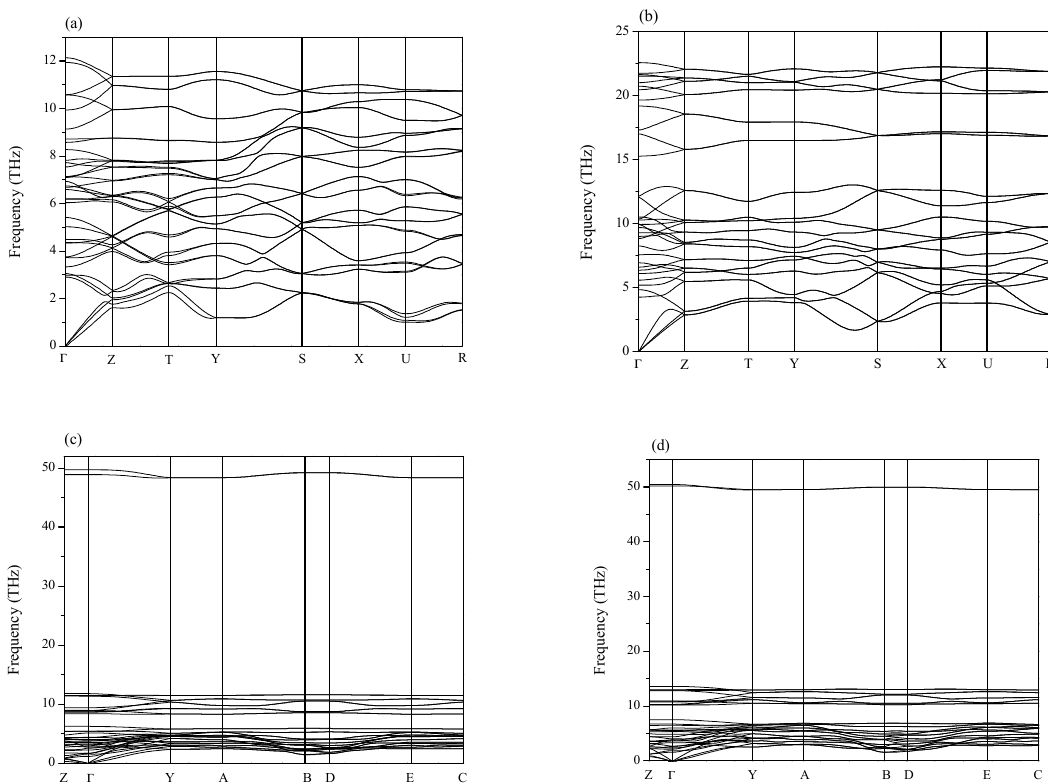
Figure 5. Phonon spectra for ( a ) Pnma -Ca 2 C at 0 GPa; ( b ) Pnma -Ca 2 C at 100 GPa; ( c ) C 2/ m -Ca 2 C at 0 GPa; ( d ) C 2/ m -Ca 2 C at 6.4 GPa.